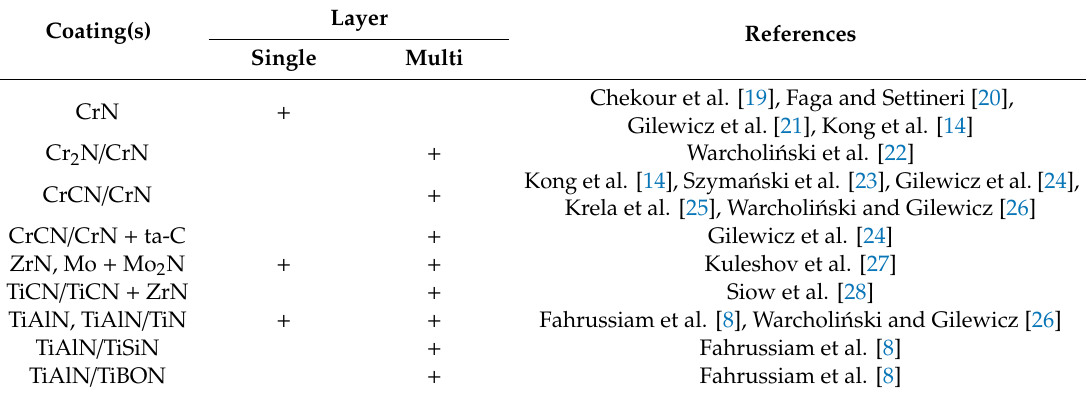
Table 1. Selected typical coatings with single and multilayer